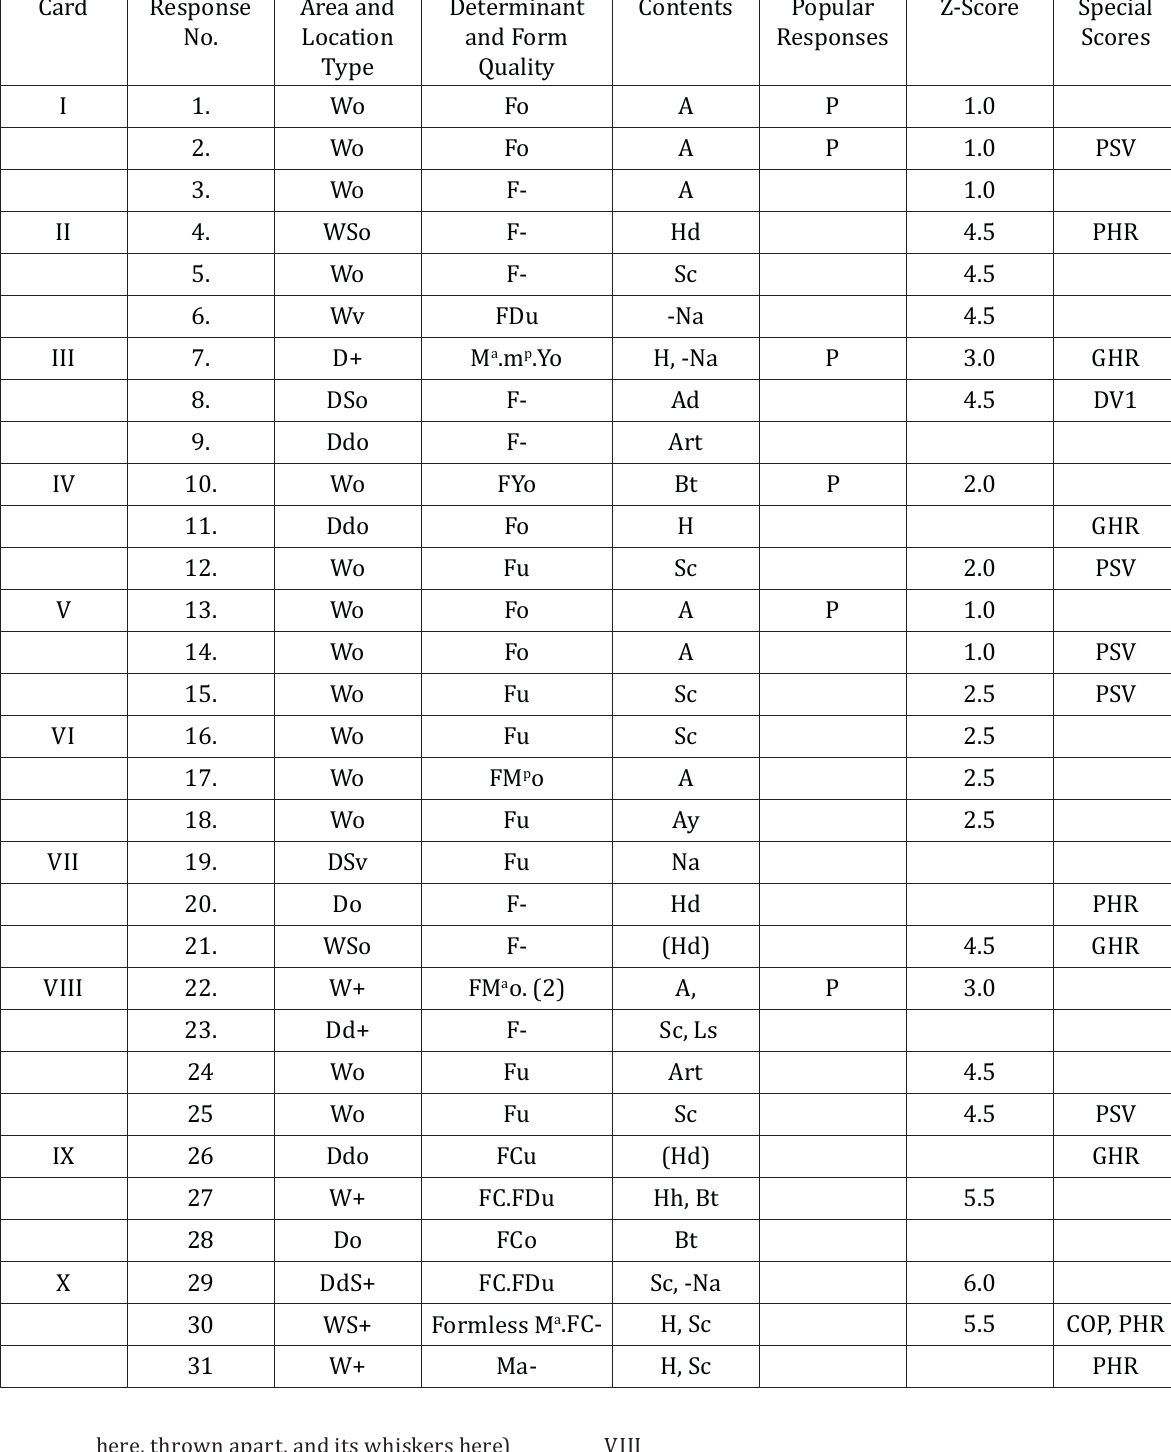
Table 2. Sequence of